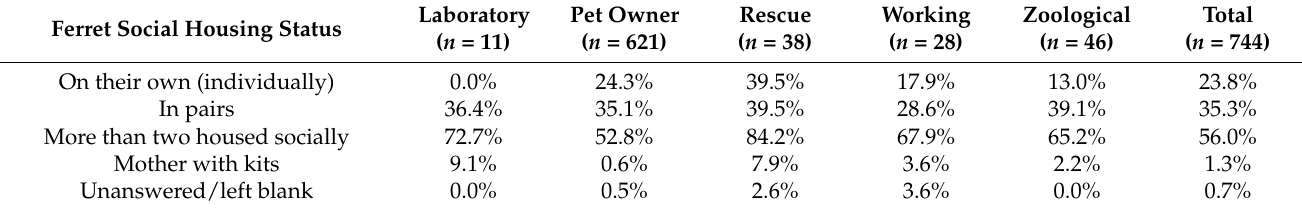
Table 1. Ferret housing status (individually or socially housed) broken down by sector. Respondents could select all applicable categories, resulting in a higher number of responses than the number of